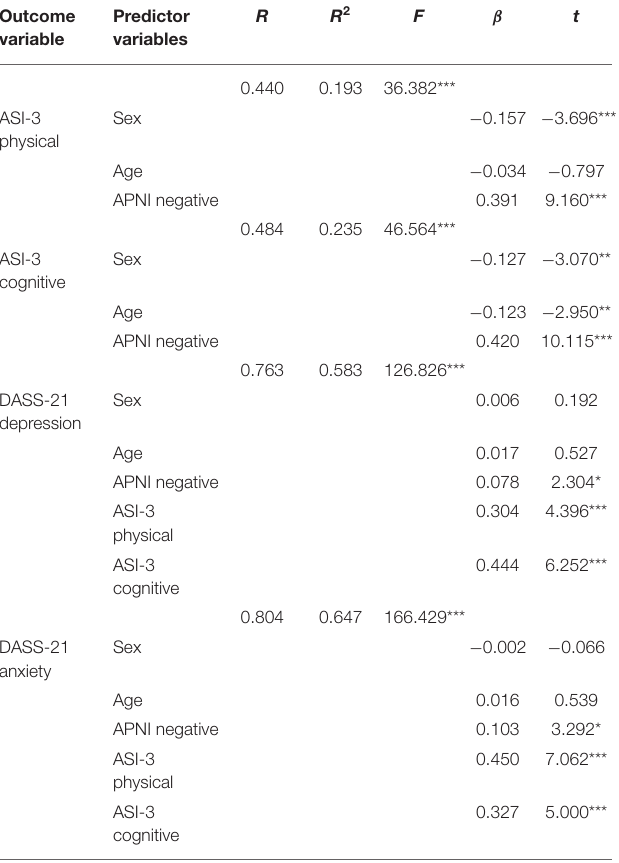
TABLE 3 | Analysis of the mediating effect of physical concern and cognitive concern on negative bias affecting depression.